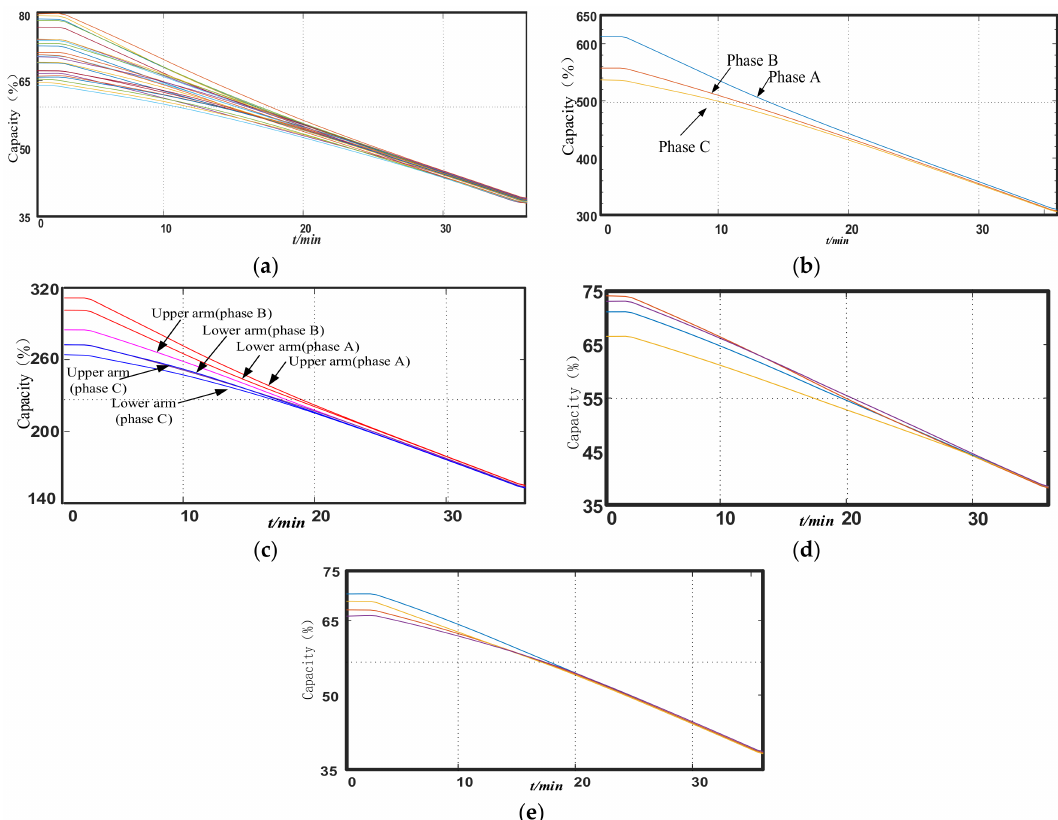
Figure 20. The experimental results of the three-level SOC balancing. ( a ) The SOC balancing of each module. ( b ) The interphase SOC balancing. ( c ) The intra-phase SOC balancing. ( d ) The SOC balancing of the upper arm of phase B. ( e ) The SOC balancing of the lower arm of phase